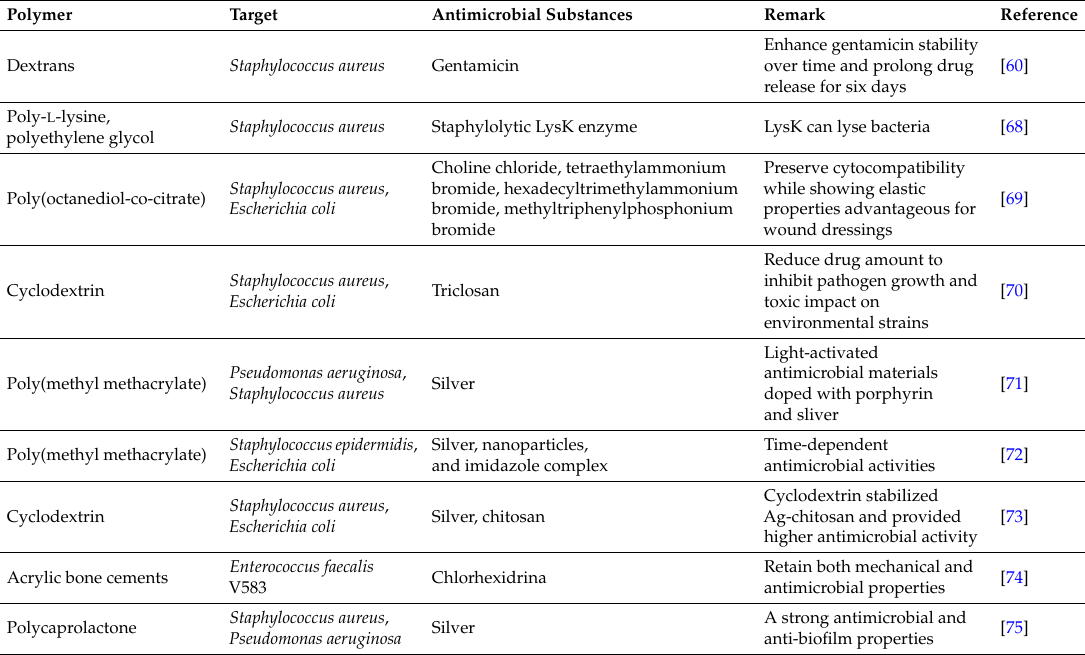
Table 6. Examples of biocide-releasing polymers for antimicrobial